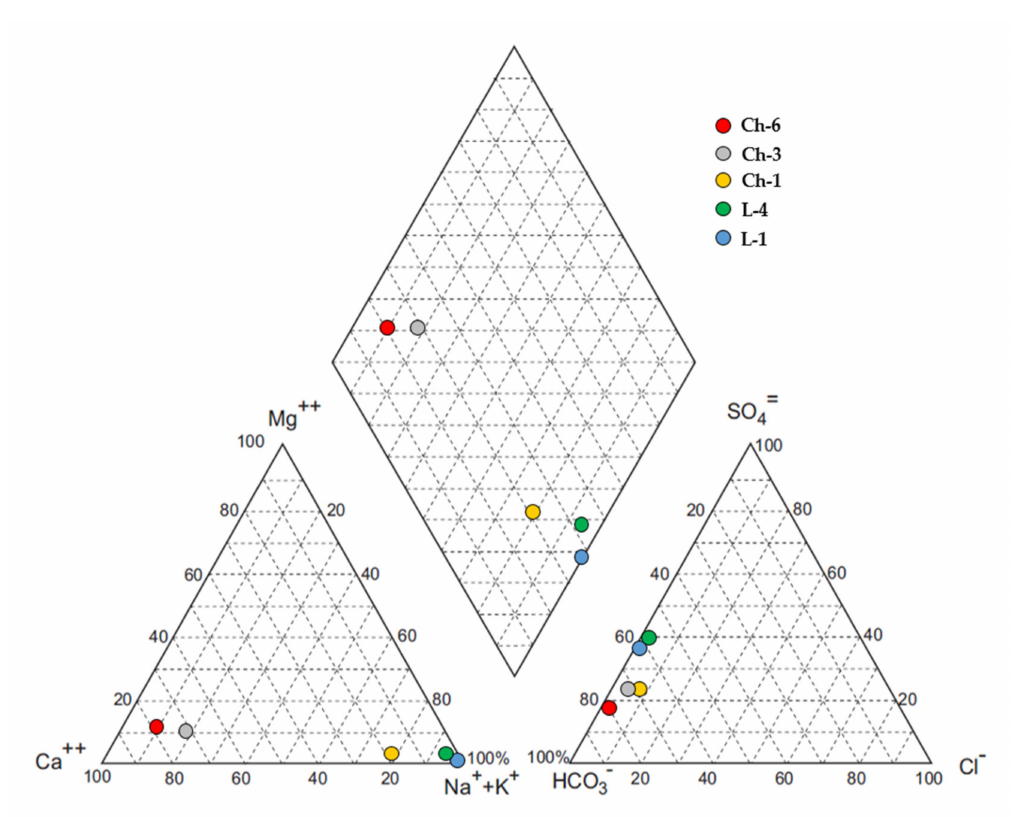
Figure 6. Piper diagram and hydrochemical types of the analysed water samples. L, leachates; Ch, surface